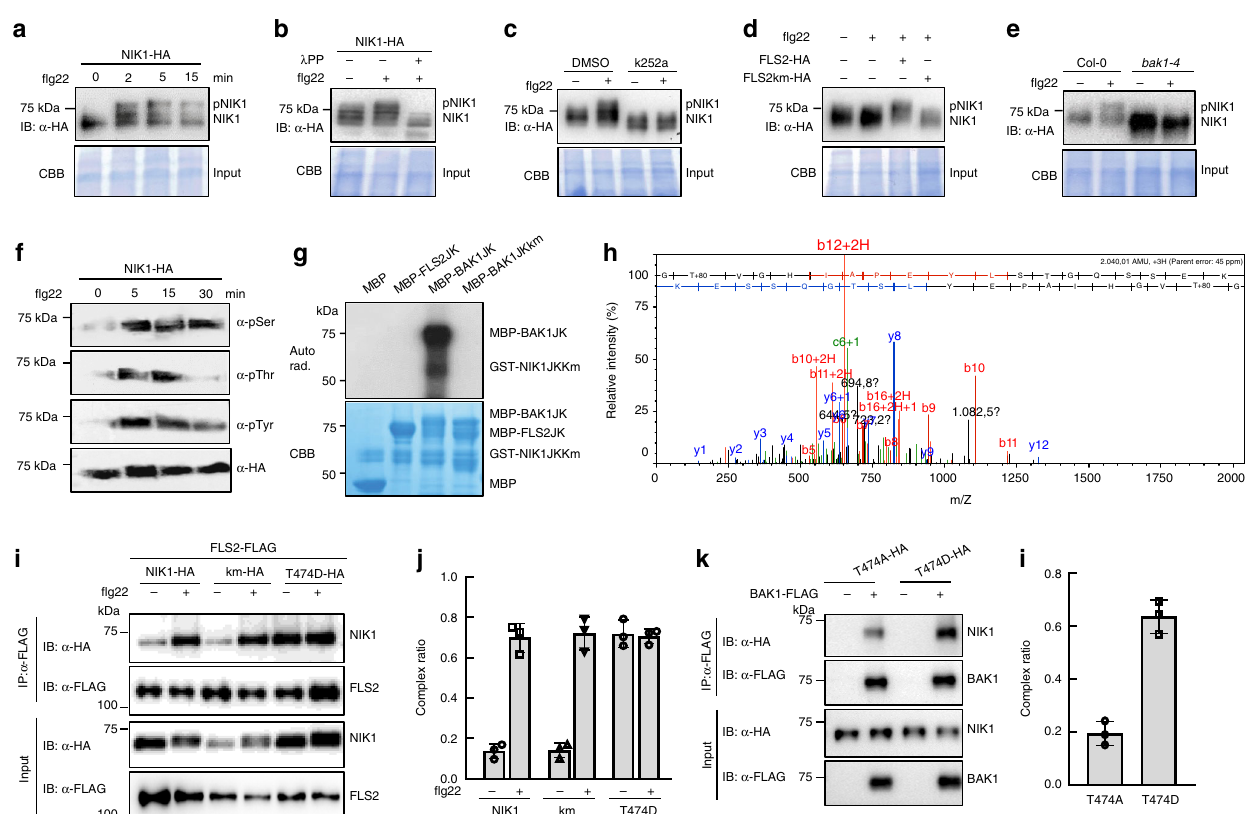
Fig. 5 Flg22 induces BAK1-mediated NIK1 phosphorylation, which enhances NIK1 ’ s af fi nity for receptors. a Flg22 perception triggers NIK1 rapid mobility shift. Protoplasts were transfected with NIK1-HA and treated with 100 nM fl g22 for the indicated time points. Total input proteins were stained with Coomassie brilliant blue staining (CBB). b Veri fi cation of NIK1 in vivo phosphorylation by λ PP treatment. Protein extracts from protoplasts transfected with NIK1-HA were treated with λ PP following the standard protocol. c The kinase inhibitor K252a blocks fl g22-induced NIK1 mobility shift. K252a was applied 1 h before fl g22 treatment. Controls were solvent (DMSO) treatment. d Flg22-induced NIK1 phosphorylation requires FLS2 and its kinase activity. Protoplasts isolated from fl s2 mutants were transfected with NIK1-HA and empty vector control, FLAG-tagged FLS2 or FLS2 kinase mutant (FLS2km). e Flg22-mediated NIK1 phosphorylation requires BAK1. NIK1-HA was expressed in protoplasts of Col-0 or bak1-4 mutants and fl g22 was applied 10 min before samples collection. f Flg22-induced in vivo phosphorylation of NIK1 detected by different phospho-antibodies. Seedlings of NIK1-HA-overexpressing lines were treated with 100 nM fl g22 for the indicated time points. NIK1-HA was immunoprecipitated from total protein extracts, fractionated by SDS-PAGE and immunoblotted with α -phosphoserine ( α -pSer), α -phosphothreonine ( α -Thr), α -phosphotyrosine ( α -Tyr) and α -HA antibodies. g BAK1, but not FLS2, directly phosphorylates the NIK1 cytosolic domain. An in vitro kinase assay was performed using MBP-FLS2JK or MBP-BAK1JK as a kinase and GST- NIK1JKKm as the substrate. Phosphorylation was analysed by autoradiography (Upper), and the protein loading was shown by CBB (Lower). h NIK1 Thr474 is phosphorylated by BAK1 in vitro as shown by MS analysis. i Phosphorylation of NIK1 promotes its interaction with FLS2. FLS2-FLAG was co-expressed with NIK1-HA, NIK1Km-HA or NIK1-T474D-HA in protoplasts. Co-IP was performed with α -FLAG Agarose (IP: α -FLAG), and the proteins were immunoblotted with an α -HA antibody (IB: α -HA). j Quantitative data ( n = 30 for h . k A NIK1 phosphomimetic form shows stronger interaction with BAK1. Co-IP assay was performed with the sample co-expressing BAK1-FLAG and T474A-HA or T474D-HA using α -FLAG Agarose. l Quantitative data from three biological replicates for j . Source data are provided as a Source Data fi The higher af fi nity of NIK1 for the FLS2/BAK1 immune receptor complex may be facilitated by phosphorylation on the Thr474 residue, as a phosphomimetic mutant NIK1-T474D displayed stronger association with FLS2 than NIK1 in the absence of fl g22 stimulation (Fig. 5i, j). Similarly, increased levels of a phosphomimetic variant were co-immunoprecipitated by BAK1 compared to non-phospho variant (Fig. 5k, l). Interaction of NIK1-T474D with BAK1 and FLS2 was also monitored by BiFC (Supplementary Fig. 6). The reconstituted YFP signal mediated by T474D interactions with the receptors was consistently stronger than those mediated by NIK1 interactions.